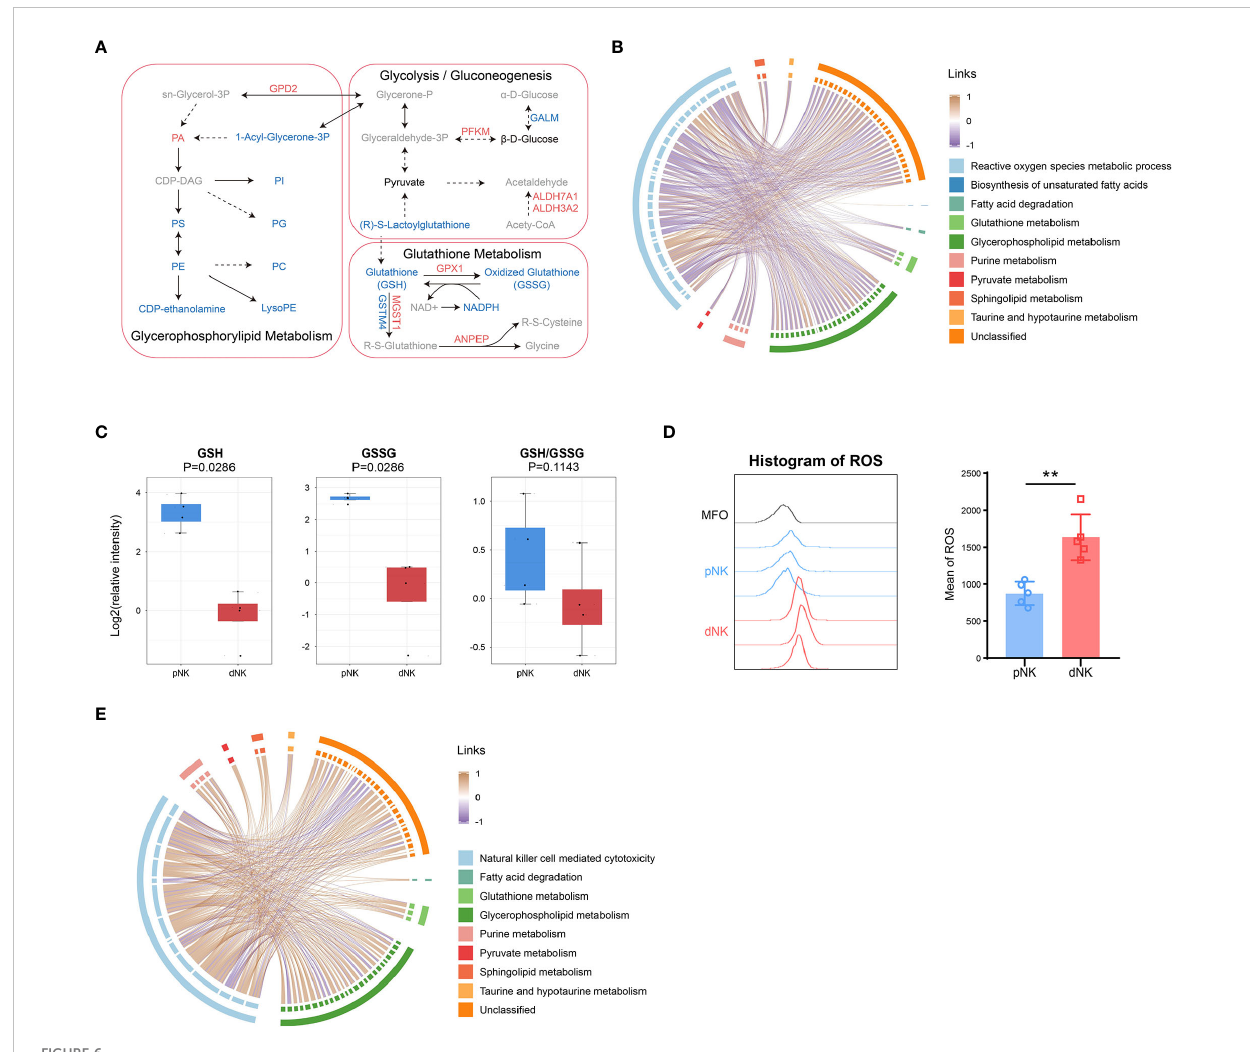
FIGURE 6 Integration of metabolomics and proteomics of dNK and pNK cells. (A) Schema of metabolic pathways (glycolysis/gluconeogenesis, glutathione and glycerophospholipid metabolism) with select metabolites and proteins. Metabolites or proteins signi fi cantly upregulated, downregulated, and unchanged were colored in red, blue, and black, respectively. Gray nodes represent metabolites that were not detected. The chord diagrams of all differential metabolites and reactive oxygen species metabolic process (B) , and natural killer cell mediated cytotoxicity (E) . Spearman correlation coef fi cients are used as links. (C) Relative intensity of metabolites involved in glutathione metabolism in pNK and dNK cells. Statistical analyses were performed by Mann – Whitney U-test. The box plots show the median and 25 th and 75 th percentiles, with whiskers indicating maximal and minimal values. (D) Expression of ROS in dNK and pNK cells. FlowJo was used to plot histogram (left) and GraphPad prism was used for statistical analysis (right). Statistical analyses were performed by two-tailed unpaired Student ’ s t -test and data were presented as mean ±